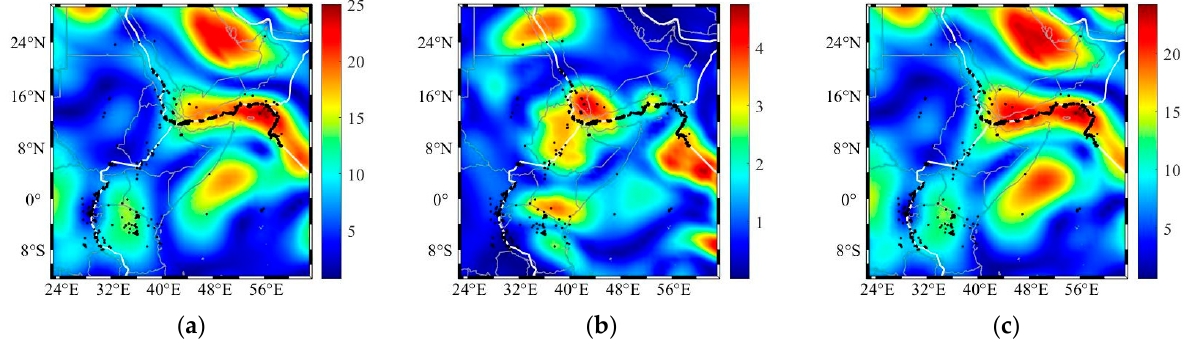
Figure 8. Maximum shear stresses at Moho surface when the lower BVs are ( a ) the horizontal shear stresses due to the mantle convection, ( b ) vertical stress due to mantle plume, and ( c ) horizontal shear and vertical stress due to the mantle convection and plume (MPa).